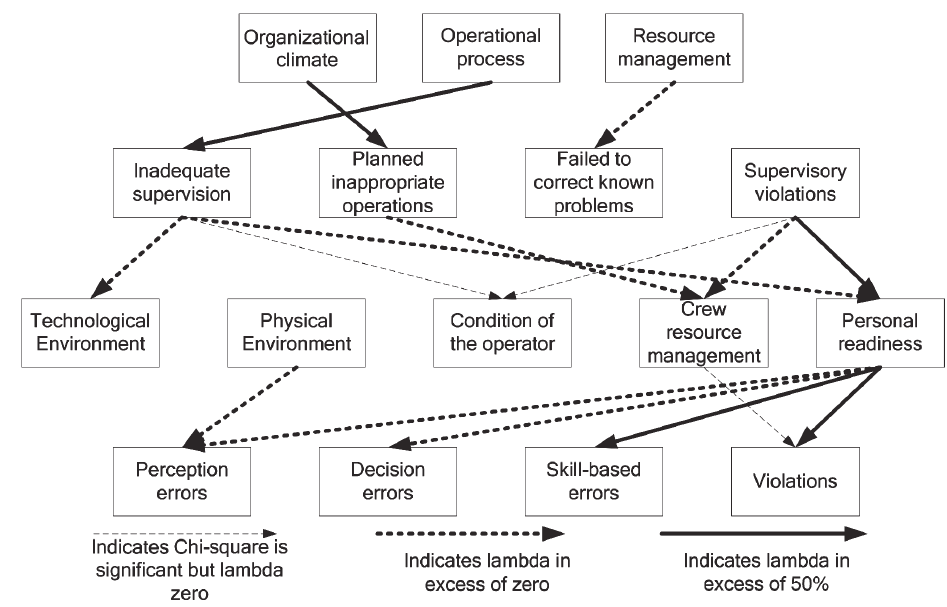
Figure 3. The simple associations graphs of traffic accident